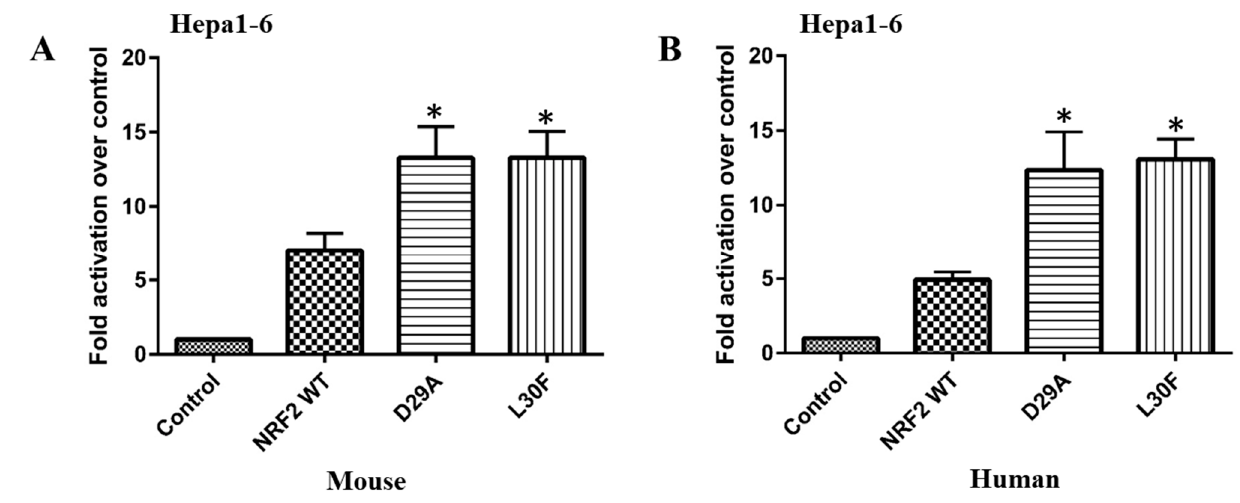
Figure 2. NRF2 MTs increase transactivation potential on its target promoter regions. ( A ). The transcriptional activity of mouse NRF2 WT and MTs. ( B ). The transcriptional activity of the human NRF2 WT and MTs in Hepa1-6 cells. In both experiments, cells were cotransfected with 3xARE luciferase reporters along with either an empty expression vector (serving as a control) or expression vectors (50 ng) for the indicated NRF2 in 24-well culture plates. The bars indicate fold activation of NRF2 WT and MTs (vs. control) on a NRF2 target promoter. Promoter activity is reported as fold activation over control. Data represent the mean ± SEM of 9 ( A ) and 5 ( B ) independent experiments (*, p < 0.05).